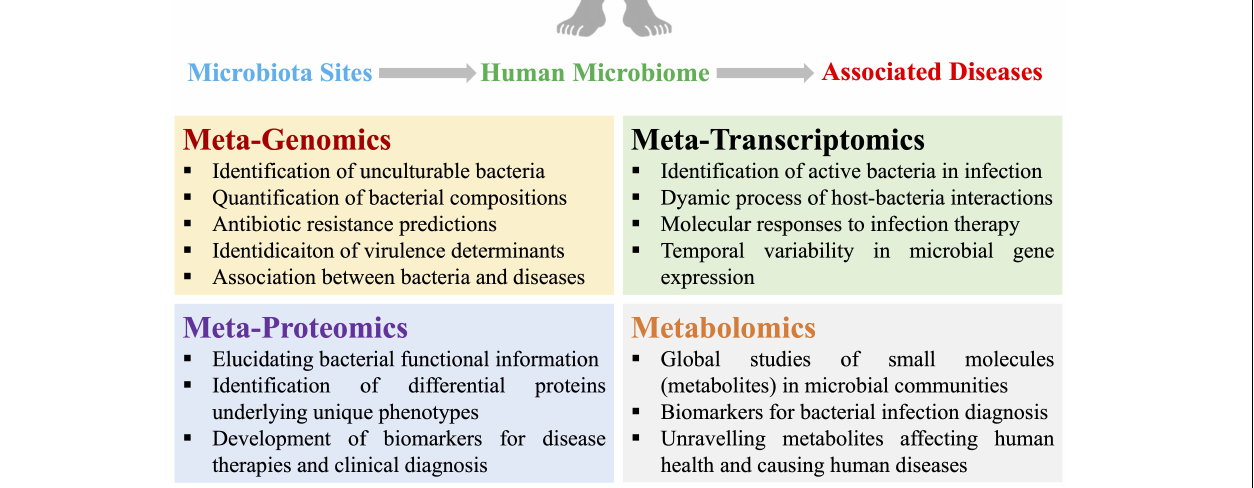
FIGURE 1 | Schematic illustration of the four omics approaches used in current and potential studies of human microbiomes and the associated diseases due to microbiota dysbiosis, which mainly involves metagenomics, metatranscriptomics, metaproteomics, and metabolomics. Representative functions of each of the four metaomics techniques were also listed. IBD, inflammatory bowel